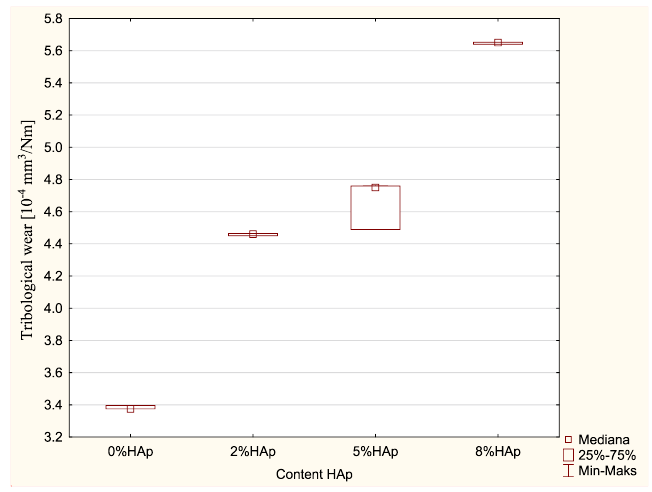
Figure 6. Statistically significant differences in tribological wear among examined groups.